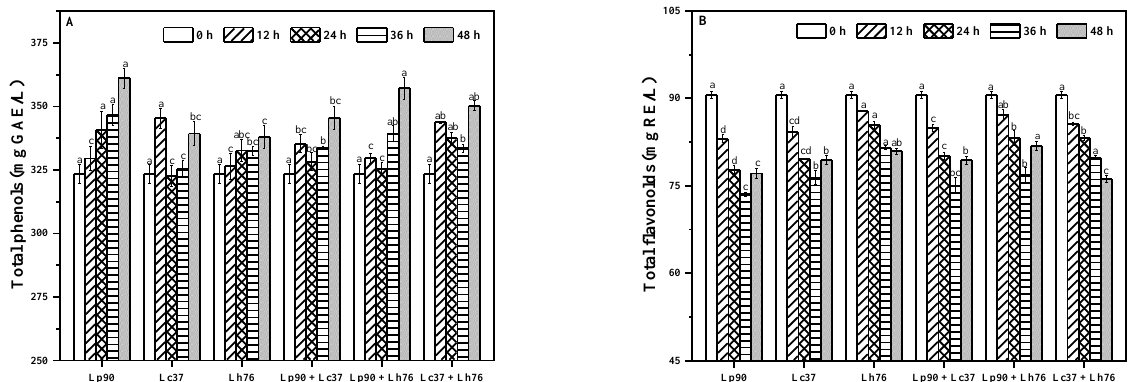
Figure 2. Total phenols ( A ) and flavonoids ( B ) contents in pear juice fermented by monoculture and binary mixture of lactic acid bacteria. Values in the same pattern column with different letters are significantly different ( p < 0.05). Abbreviations: Lp90, Lactiplantibacillus plantarum 90; Lc37, Lacticaseibacillus casei 37; Lh76, Lactobacillus helveticus 76; Lp90 + Lc37, mixture of Lactiplantibacillus plantarum 90 and Lacticaseibacillus casei 37; Lp90 + Lh76, mixture of Lactiplantibacillus plantarum 90 and Lactobacillus helveticus 76; Lc37 + Lh76, mixture of Lacticaseibacillus casei 37 and Lactobacillus helveticus 76.